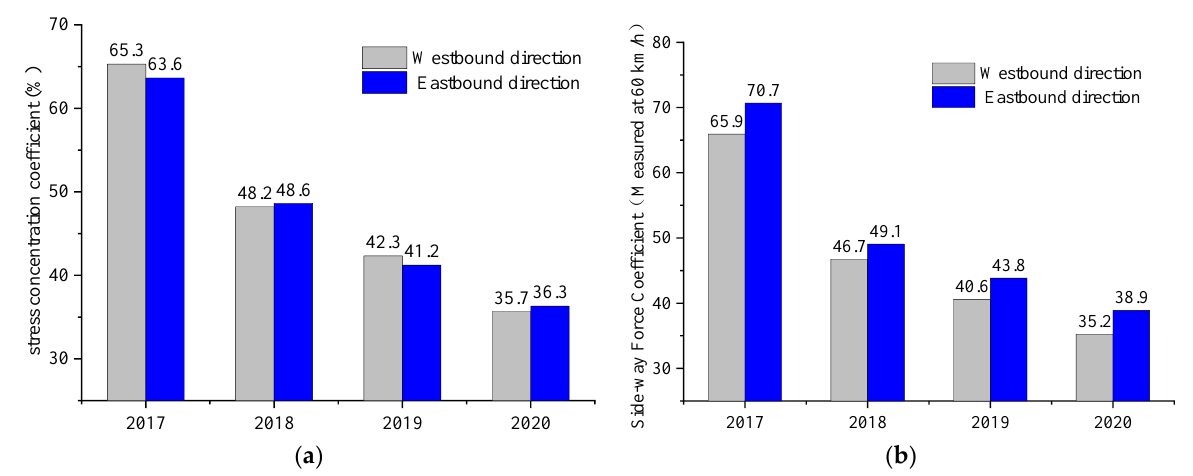
Figure 17. Tracking data: ( a ) stress concentration coefficient; ( b ) sideway-force coefficient (60 km/h). Overall, the decrease percentages of the stress concentration coefficient of westbound and eastbound direction in the first year are 57.8% and 55.0%, respectively, whereas the corresponding values of the SFC are 62.1% and 68.0%. Under the effect of significant abrasion, the skid-resistance performance decreases rapidly in the initial stage, consistent with the laboratory test results. Figure 18 shows the correlation analysis results of the stress concentration factor and transverse force coefficient. The R 2 of the test data is 0.871, indicating a good linear correlation between the tire contact stress concentration coefficient and sideway-force coefficient. Therefore, the stress concentration coefficient based on the friction mechanics can be used to characterize the skid-resistance of textured concrete pavements.